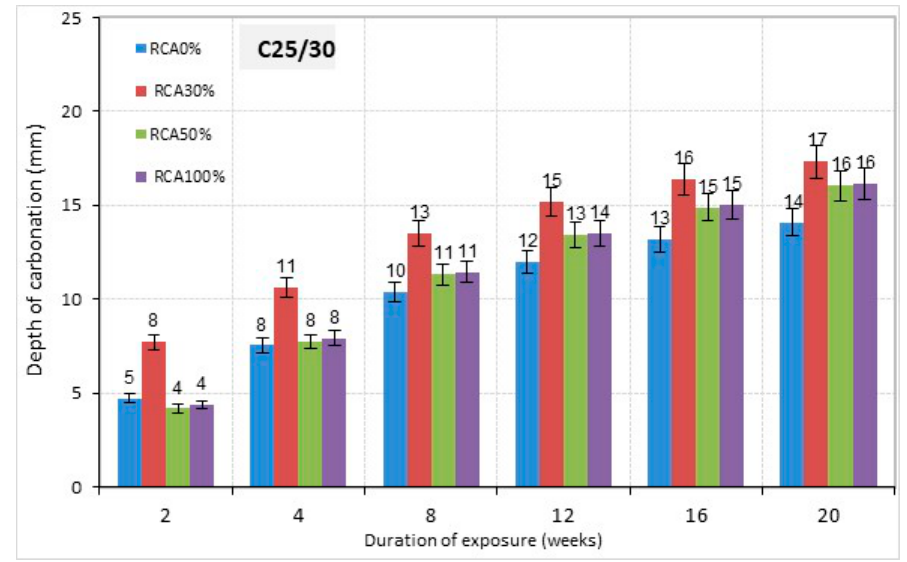
Figure 16. Depth of carbonation versus the exposure duration of C25/30 concretes.